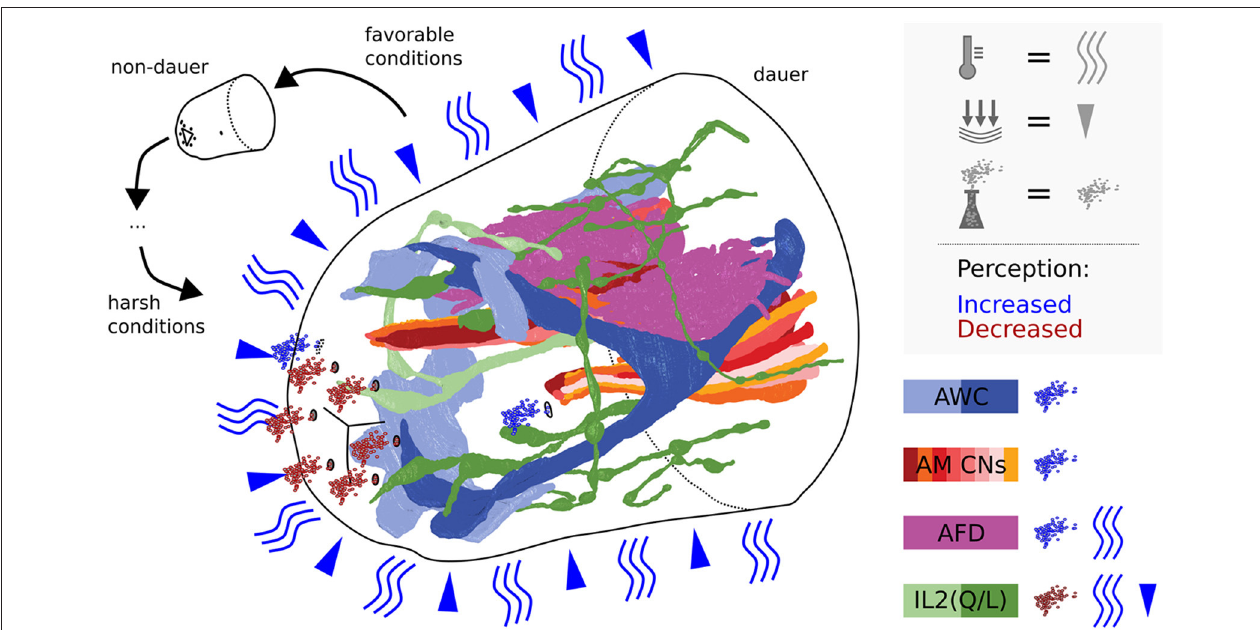
FIGURE 8 | Scheme summarizing dauer remodeled anterior sensilla neuron endings in the context of perception of environmental cues. The perceptive field of IL2s is extended by dendritic branching putatively allowing to sense mechanical stimulations and/or temperature. Cilia endings of IL2s are retracted suggesting reduction of potential chemosensitivity. Note that IL channels might be constricted in dauer, reducing chemical passage. AWCs are expanded in their wingspan and AFDs in their number of microvilli speaking for increased sensitivity. Amphid channels are open, allowing amphid neurons to efficiently sense certain volatile cues present in the